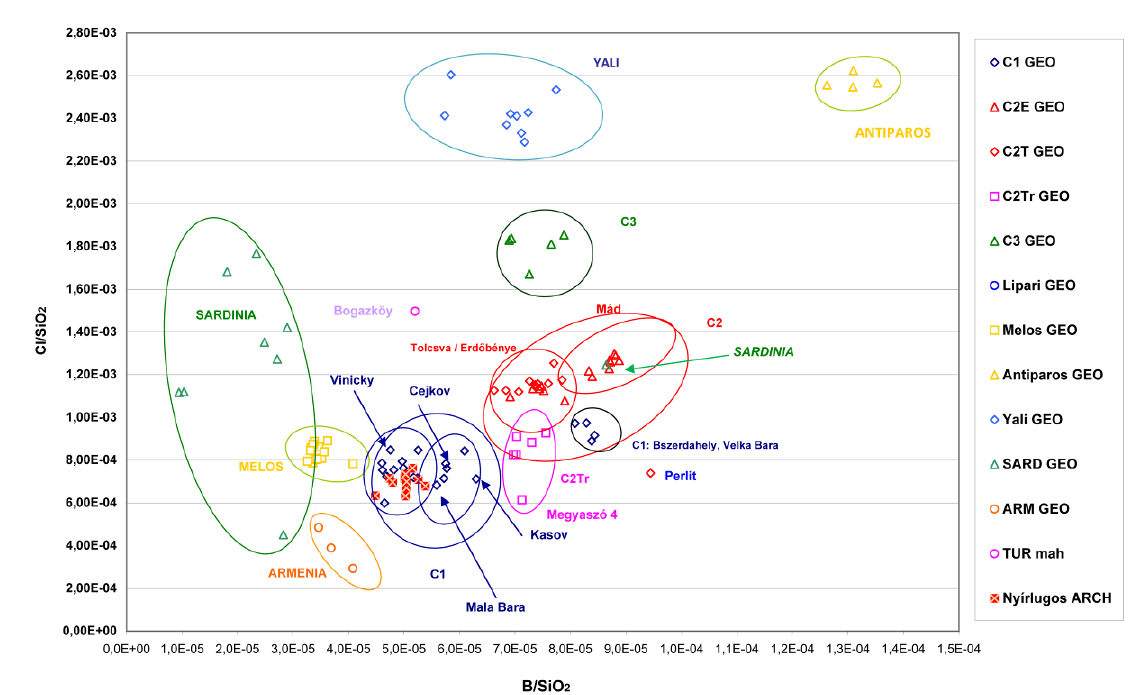
Figure 6. Separation of obsidian source regions on the basis of B/SiO hoard is compared with geological reference samples - detail of Figure